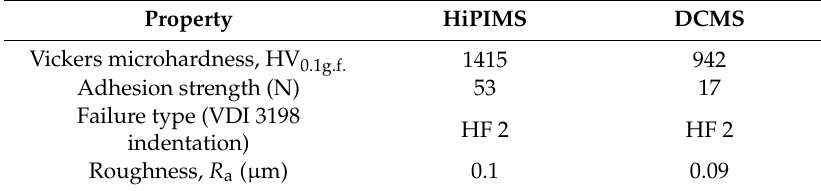
Figure 3. Optical micrograph for Rockwell indents on TiN coatings deposited by ( a ) HiPIMS and ( b ) DCMS onto high speed steel. Table 2. Comparison of mechanical properties at room temperature between TiN deposited by HiPIMS and DCMS